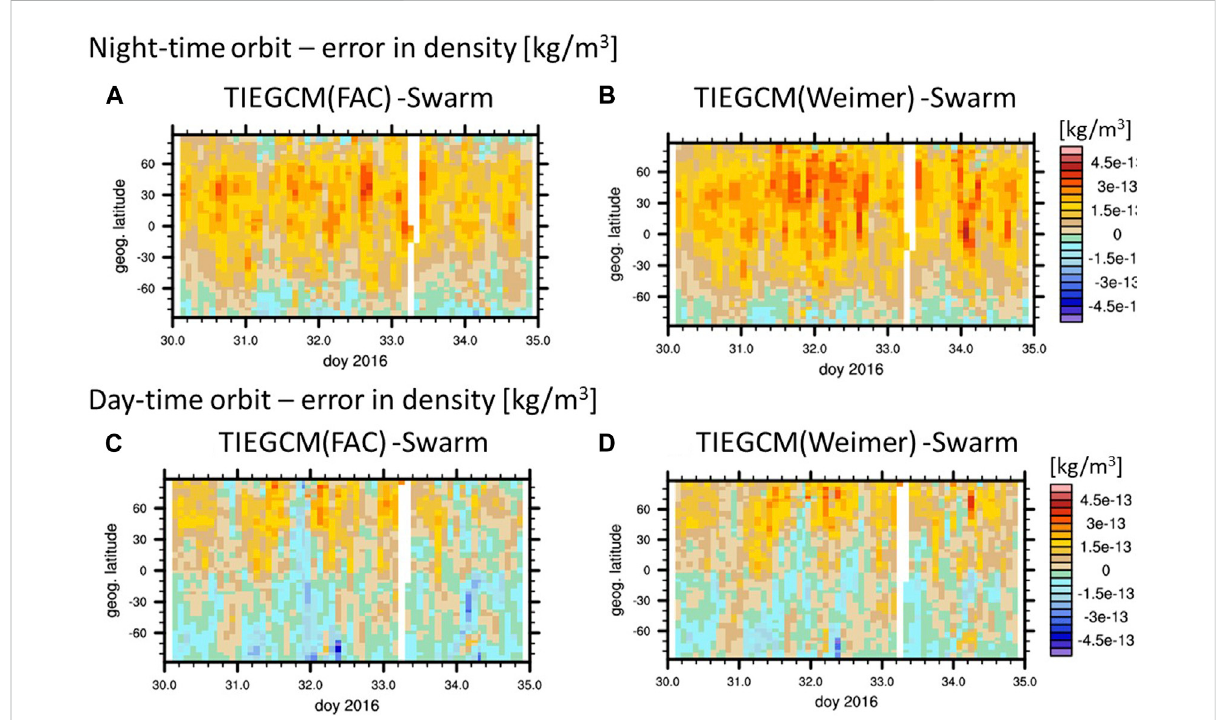
FIGURE 8 Neutral density difference between TIEGCM(FAC) and Swarm-C (A) and (C) and between TIEGCM(Weimer) and Swarm-C (B) and (D) for night- time orbit (A) and (B) and day-time orbit (C) and (D)